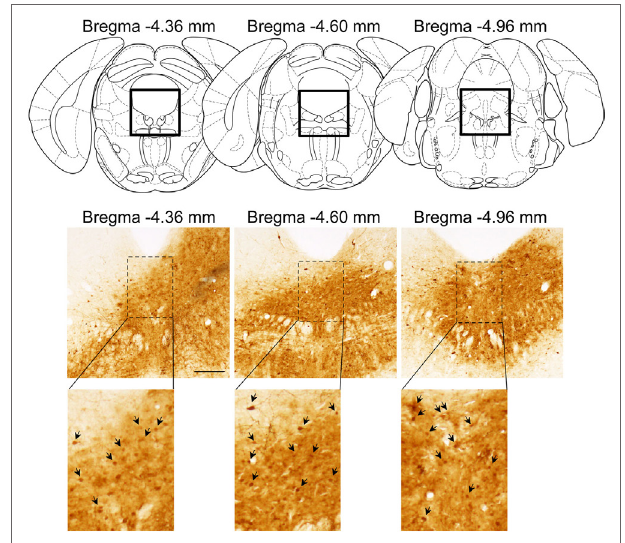
FigUre 3 | Representative distribution pattern of adeno-associated virus within the dorsal raphe nucleus determined based on green fluorescent protein immunohistochemistry. The scale bar represents 200 µm.